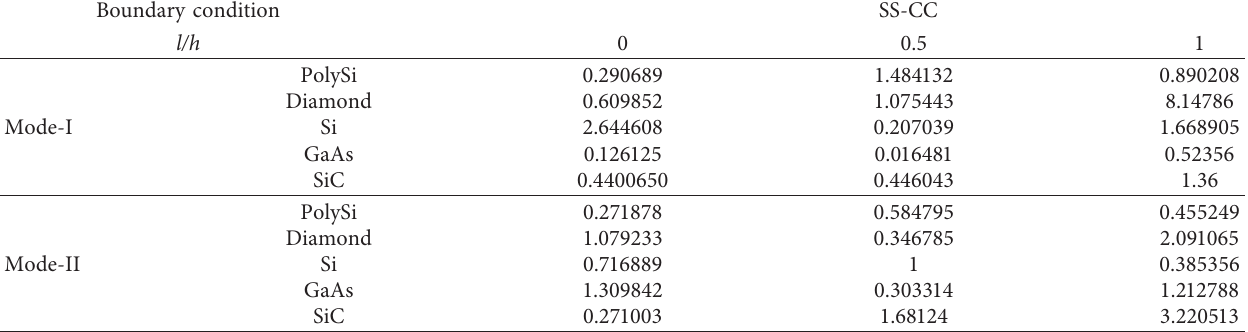
Table 5: Variation of Q TED (%) of a microplate for different boundary